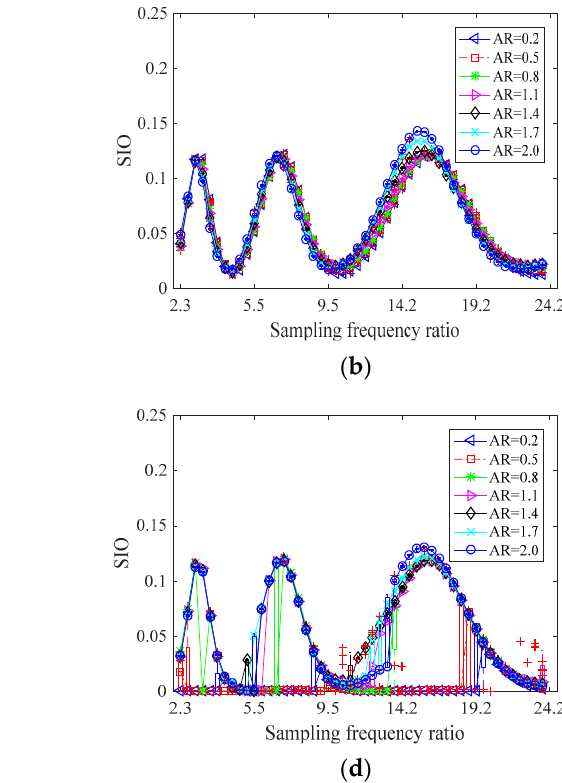
Table 3. Decomposing results of ICEEMDAN (SFR = 21.7, AR = 0.5). ( ) x k SIO RRSE of 2